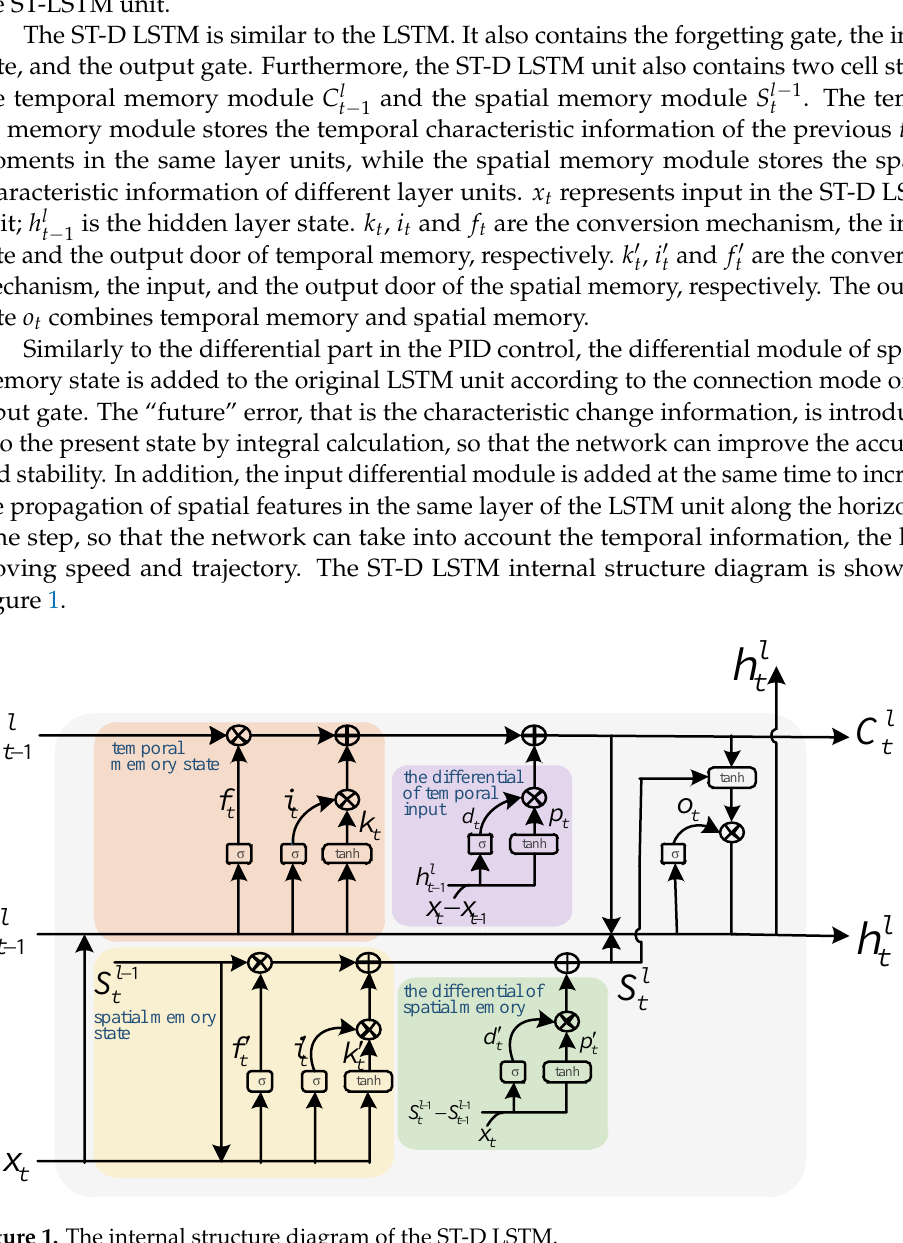
Figure 1. The internal structure diagram of the ST-D